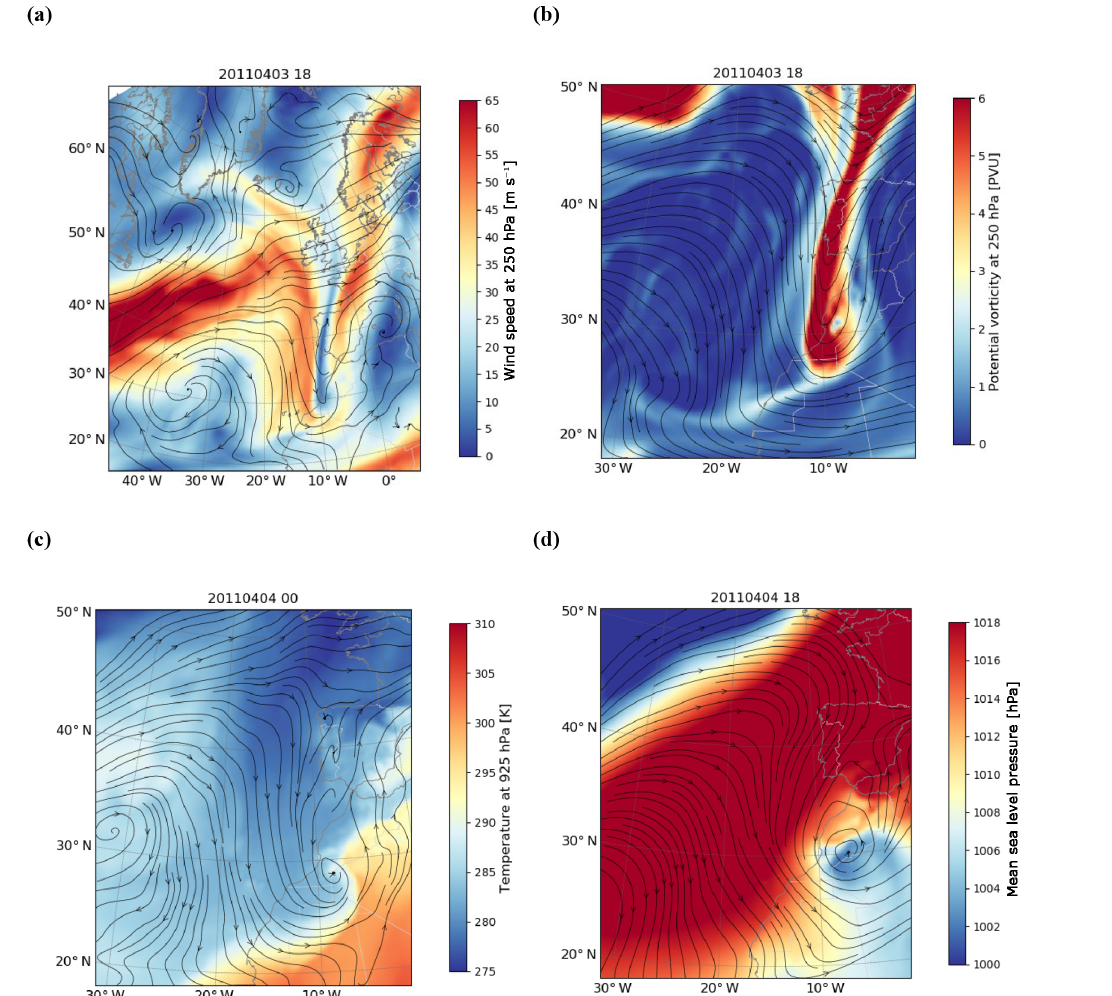
Figure 1. ECMWF ERA5 reanalyzes at 250hPa on 3 April at 18:00UTC of Wind Speed (a) and Potential Vorticity (b) . (c) ERA5 reanalyses for temperature at 925hPa on 4 April 2011 at 00:00UTC. (d) ERA5 MSLP on 4 April 2011 at 18:00UTC. ERA5 wind direction at 700hPa is superimposed on all the figures by the black